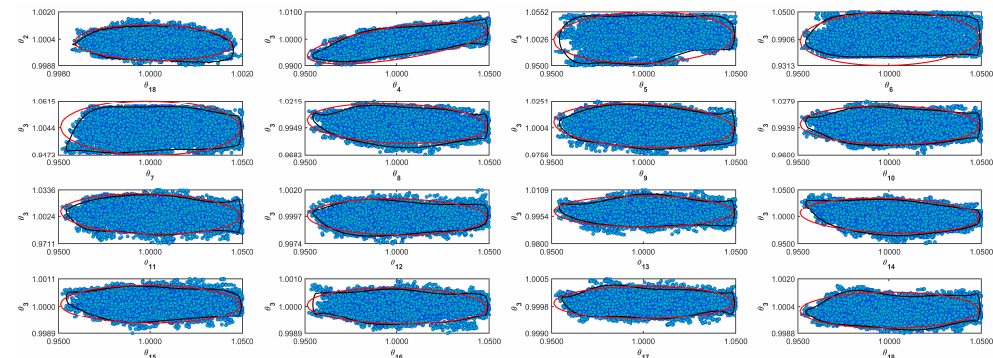
Figure A3. Coverage regions of parameters 03: (—) Gaussian region; (—) Possolo [33] region.